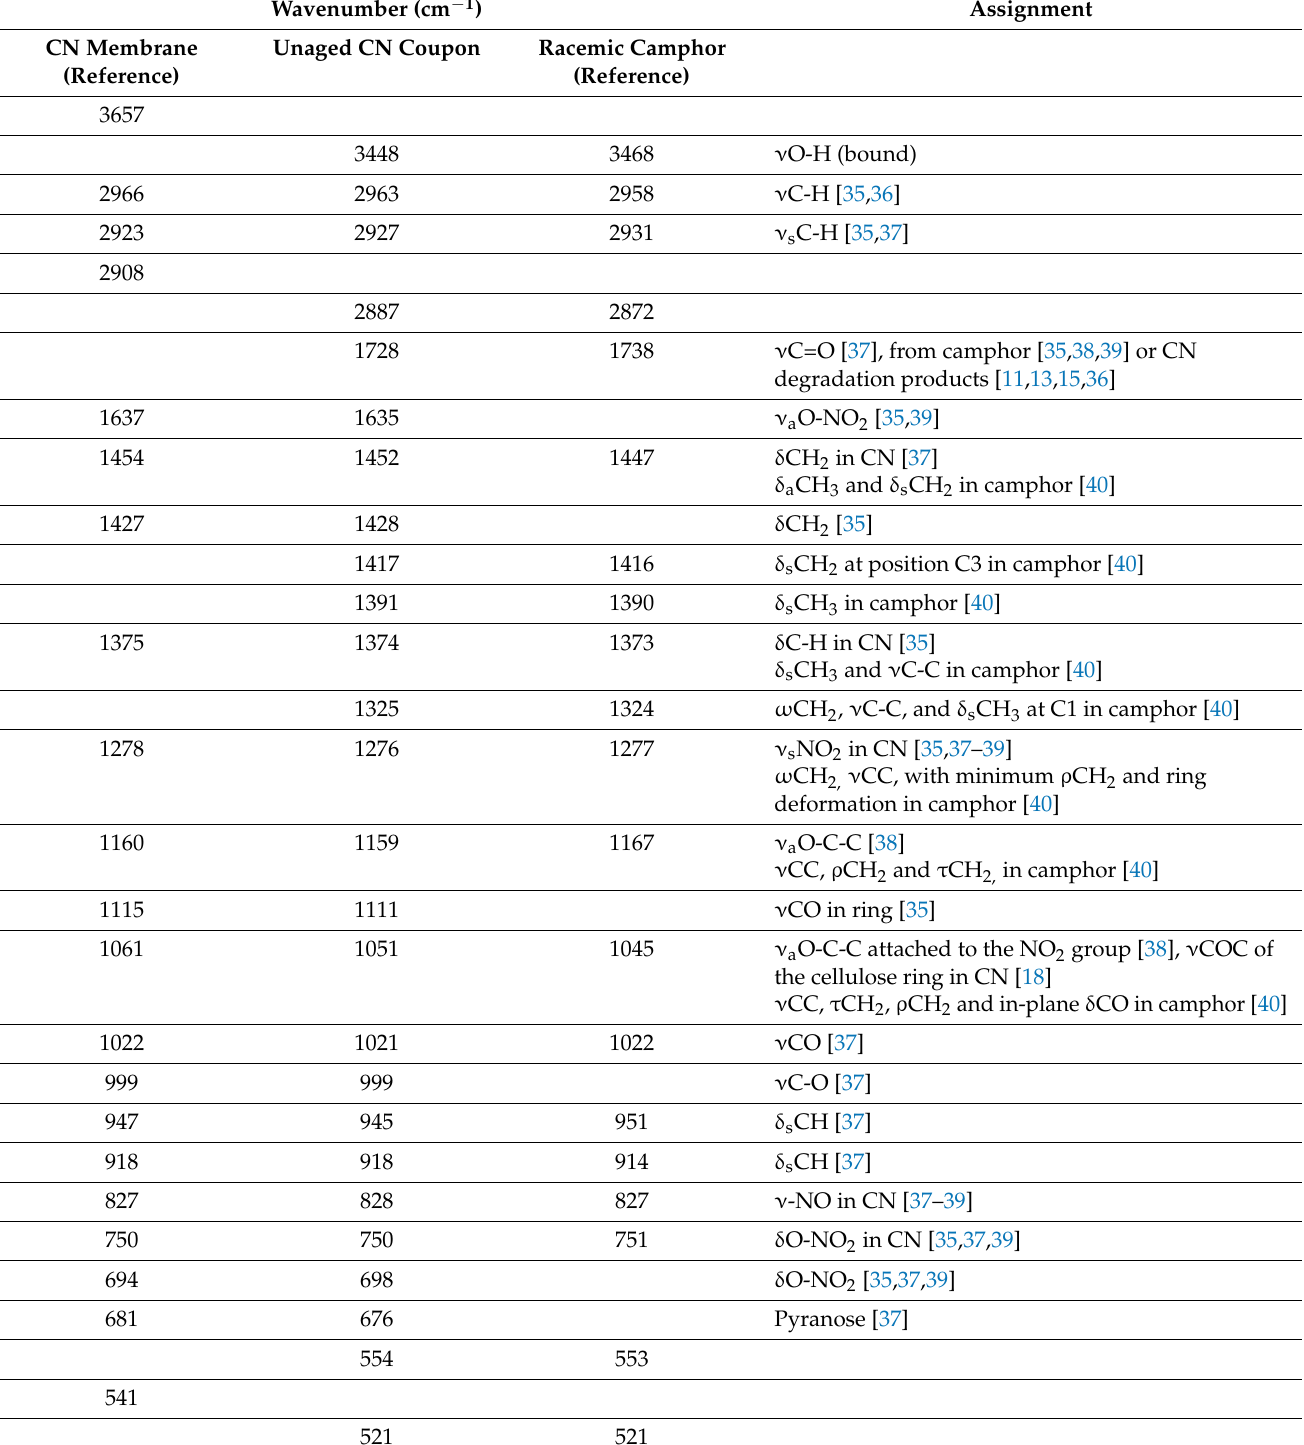
Table 1. Assignment of the main bands of the ATR-FTIR spectra depicted in Figure